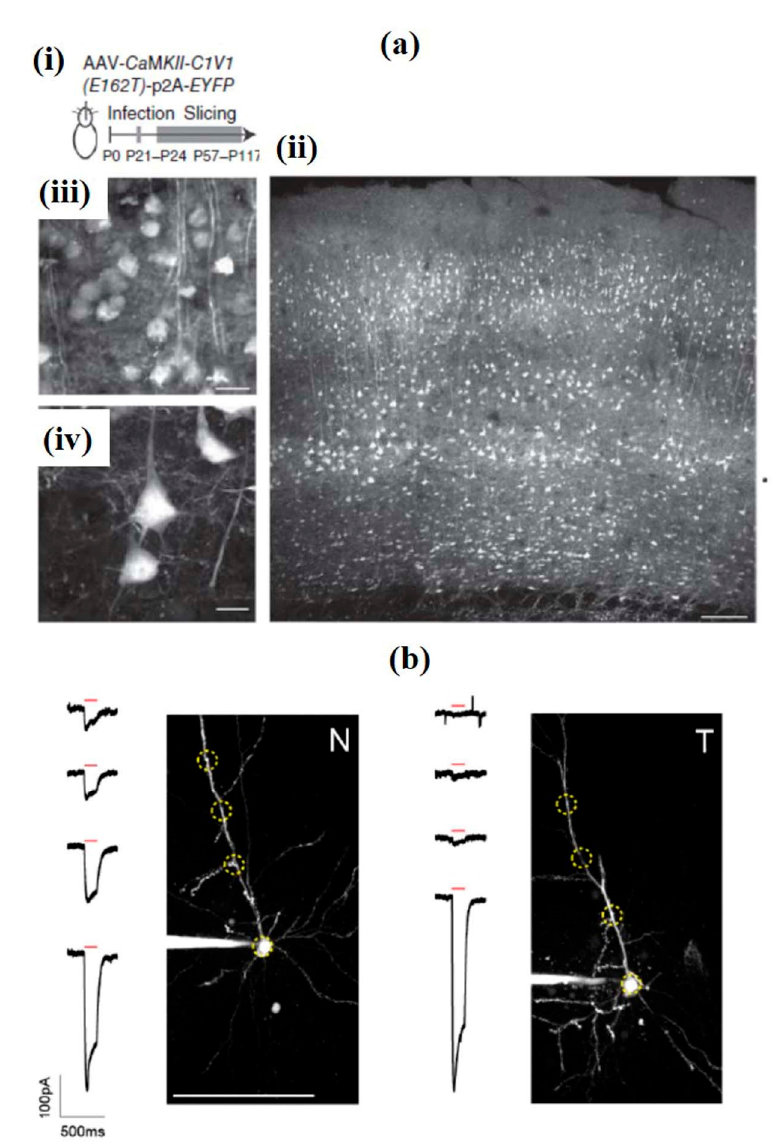
Figure 17. ( a ) Two-photon activates of individual neurons present in mouse brain slices with C1V1T. ( i ) The experimental scheme shows the opsin C1V1T and EYFP genes encoded by Adeno-associated virus (AAV) are inserted in the somatosensory cortex of the mouse. Brain slices were prepared at a designated time point from the infected region. ( ii ) Two-photon fluorescence image of a living cortical brain slice expressing EYFP (940-nm excitation, 15 mW on the sample, 25 × / 1.05-NA objective; scale bar, 100 µ m). ( iii , iv ) Magnified images from ( b ) show cells with C1V1T-expression present in higher ( iii ) and lower ( iv ) layers (scale bars, 20 µ m ( iii ), and 10 µ m ( iv ) Reprinted with permission from [180]. ( b ) Illustrative two-photon highest intensity projections of Alexa 594 fluorescence and current responses against a single 150 ms temporal focusing (TF) stimulation pulse (red bar) for patched and dye-filled pyramidal cells present in acute slices expressing targeted (T) and nontargeted (N) ChR2. Scale bar = 100 mm. Reprinted with permission from